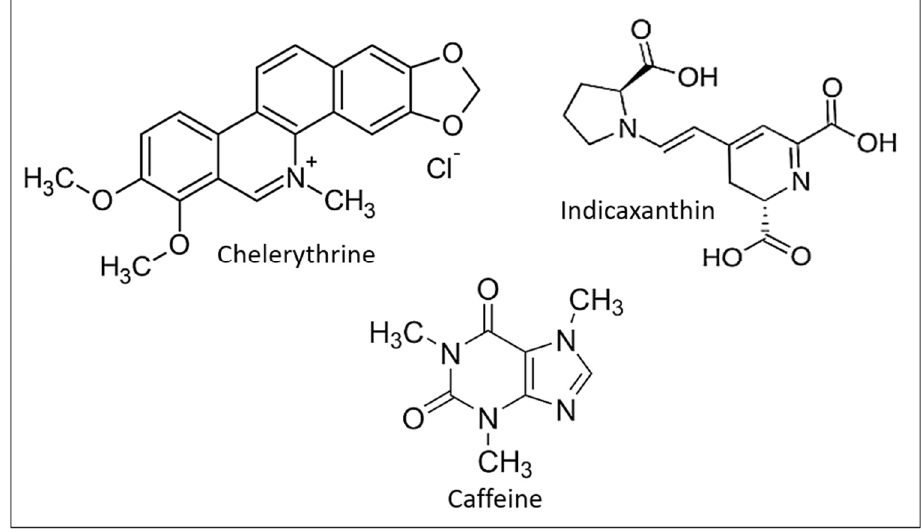
Figure 5. Chemical structure of some alkaloid compounds with anti-eryptotic activity.